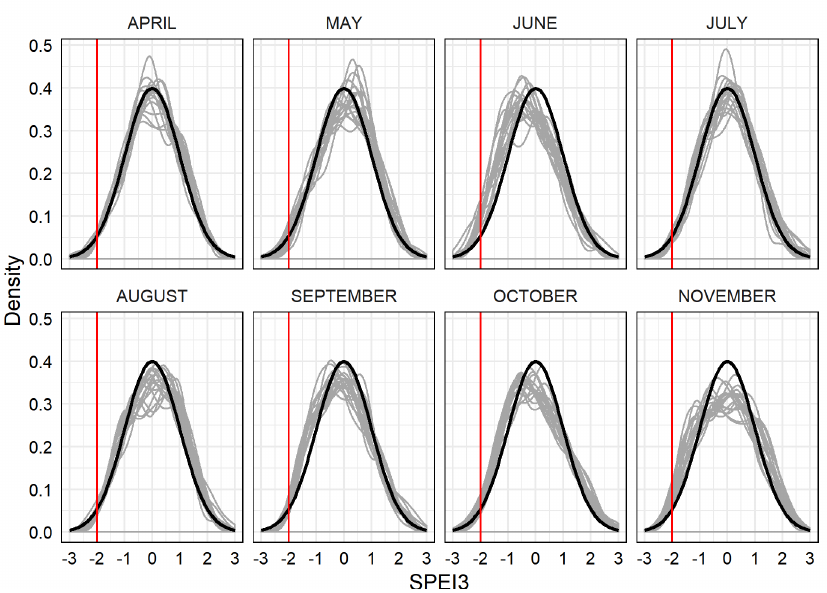
Fig. 3. Normal distribution (black line) and distribution of SPEI3 values in different months of the growing season at 18 Lithuanian meteorological stations (grey lines). The red vertical line represents the threshold below which SPEI3 values indicate extreme